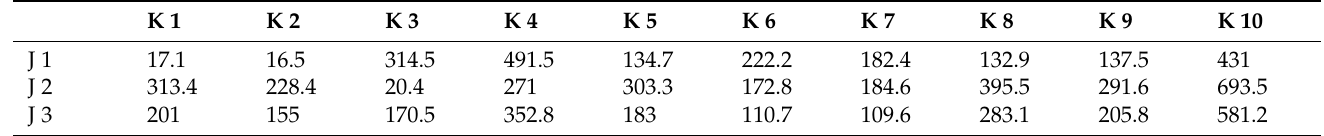
Table A3. Distance between distribution center J and sales/collection center K